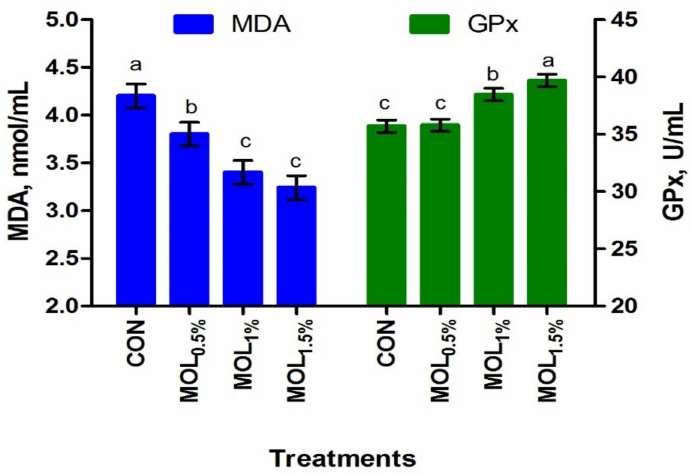
Figure 2. Blood antioxidant capacity of growing rabbits fed the experimental diets. a–c Means with various letters within each parameter are different at p < 0.05. The experimental diets were a basal diet as control (CON) and experimental diets contented 5, 10, or 15 g/kg Moringa oleifera leaves (MOL 0.5%, MOL 1%, and MOL 1.5% , respectively). Means are presented ± SEM. MDA = malondialdehyde, GPx = glutathione peroxidase.